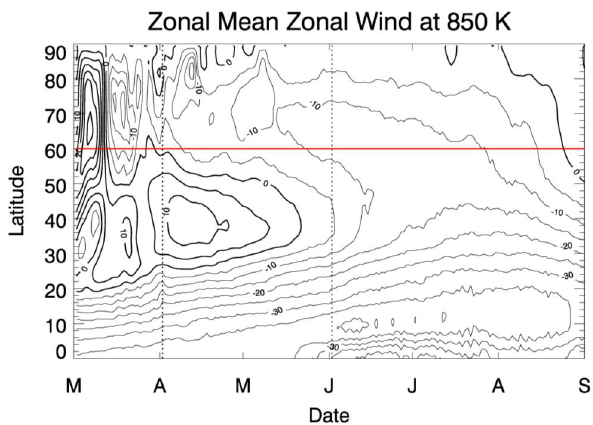
Fig. 1. Zonal mean zonal wind at 850K potential temperature for Figure 1. Zonal mean zonal wind at 850 K potential temperature for March–August 2005. 2 March–August 2005. Vertical dotted lines indicate transitions be- Vertical dotted lines indicate transitions between the three phases of the FrIAC (see text for 3 tween the three phases of the FrIAC (see text for details), while the details), while the red line marks 60°N latitude. 4 red line marks 60 ◦ N